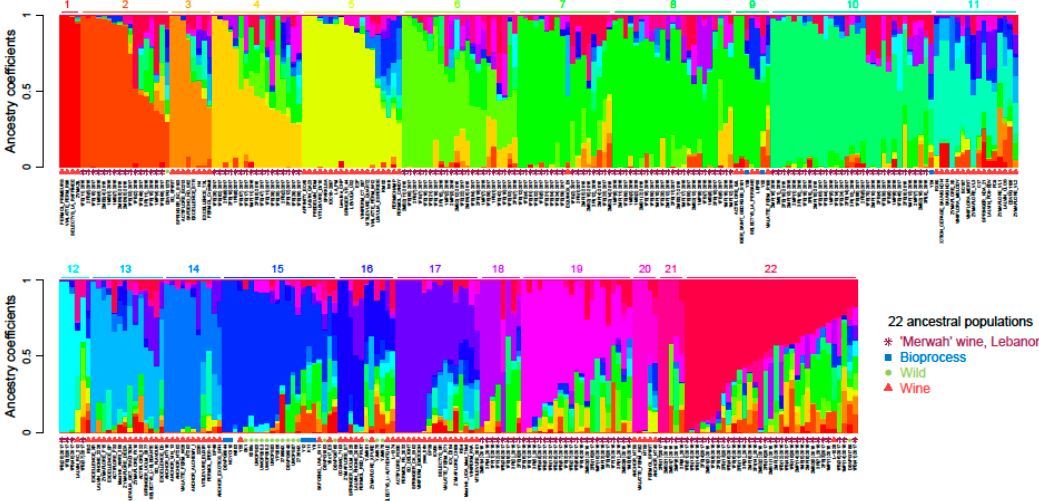
Table 4. Pairwise fixation indices calculated using the distance matrix.